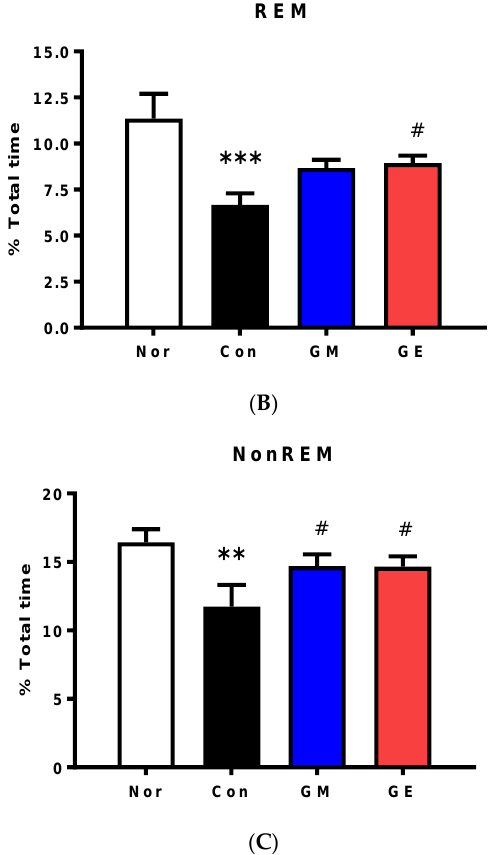
Figure 2. The effect of GM and GE on sleep architecture in the EFS-stressed rat. Changes in the percentage of wake ( A ), REM sleep ( B ), and NREM sleep ( C ) after GM and GE administration. The data represent the mean ± SEM of percent time spent in the sleep–wake state. ** p < 0.01, *** p < 0.001 vs. No (no stress); # p < 0.05, ## p < 0.01, vs. control (saline with EFS); one-way ANOVA followed by Tukey’s test. Normal (n = 6), control (n = 6), GM (n = 6), GE (n = 6).